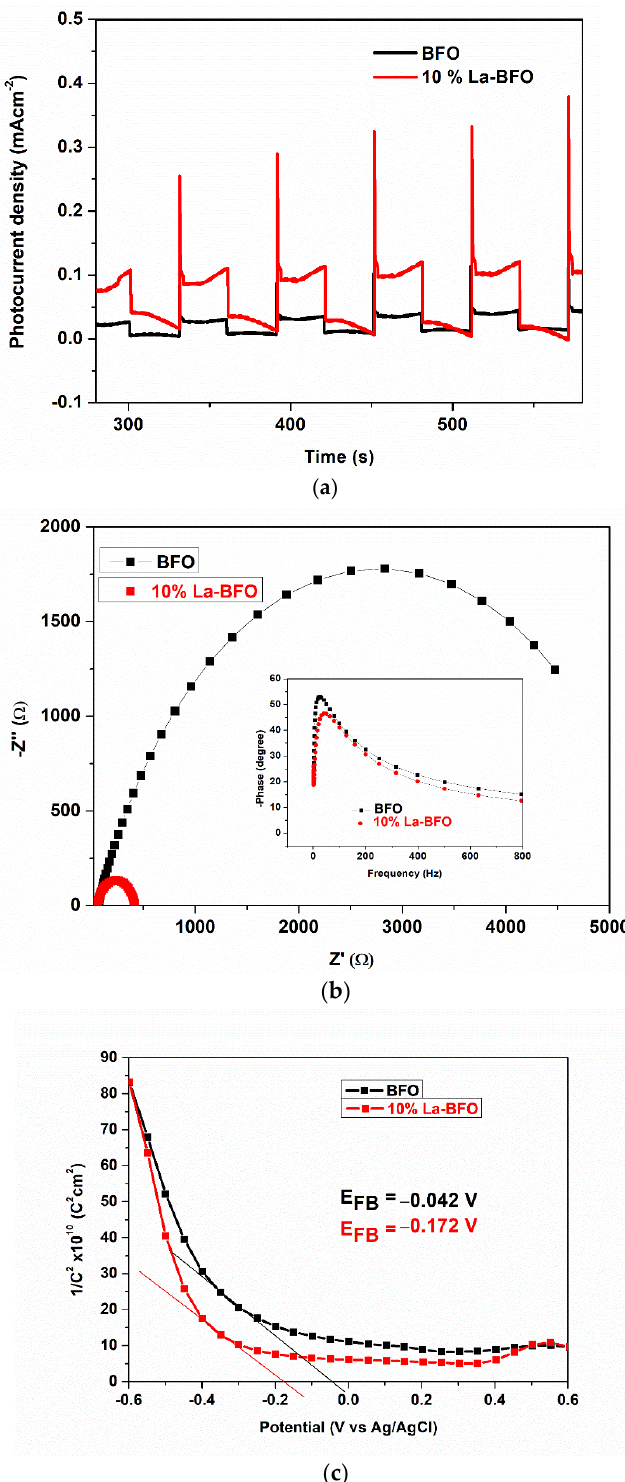
Figure 3. ( a ) Photocurrent response; ( b ) Nyquist EIS plot obtained with external bias potential of 0.23 V, amplitude of 0.01 V and frequency range of 100 kHz to 0.1 Hz, (insert: Bode plot); ( c ) Mott – Schottky plot for BFO and 10% La-BFO pho-